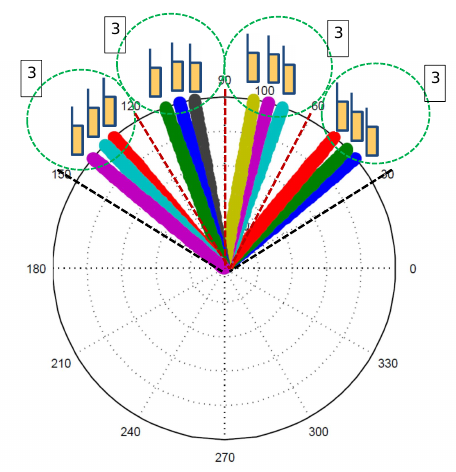
Figure 4. Dense user equipment (UE) distribution (SUD) scenario.